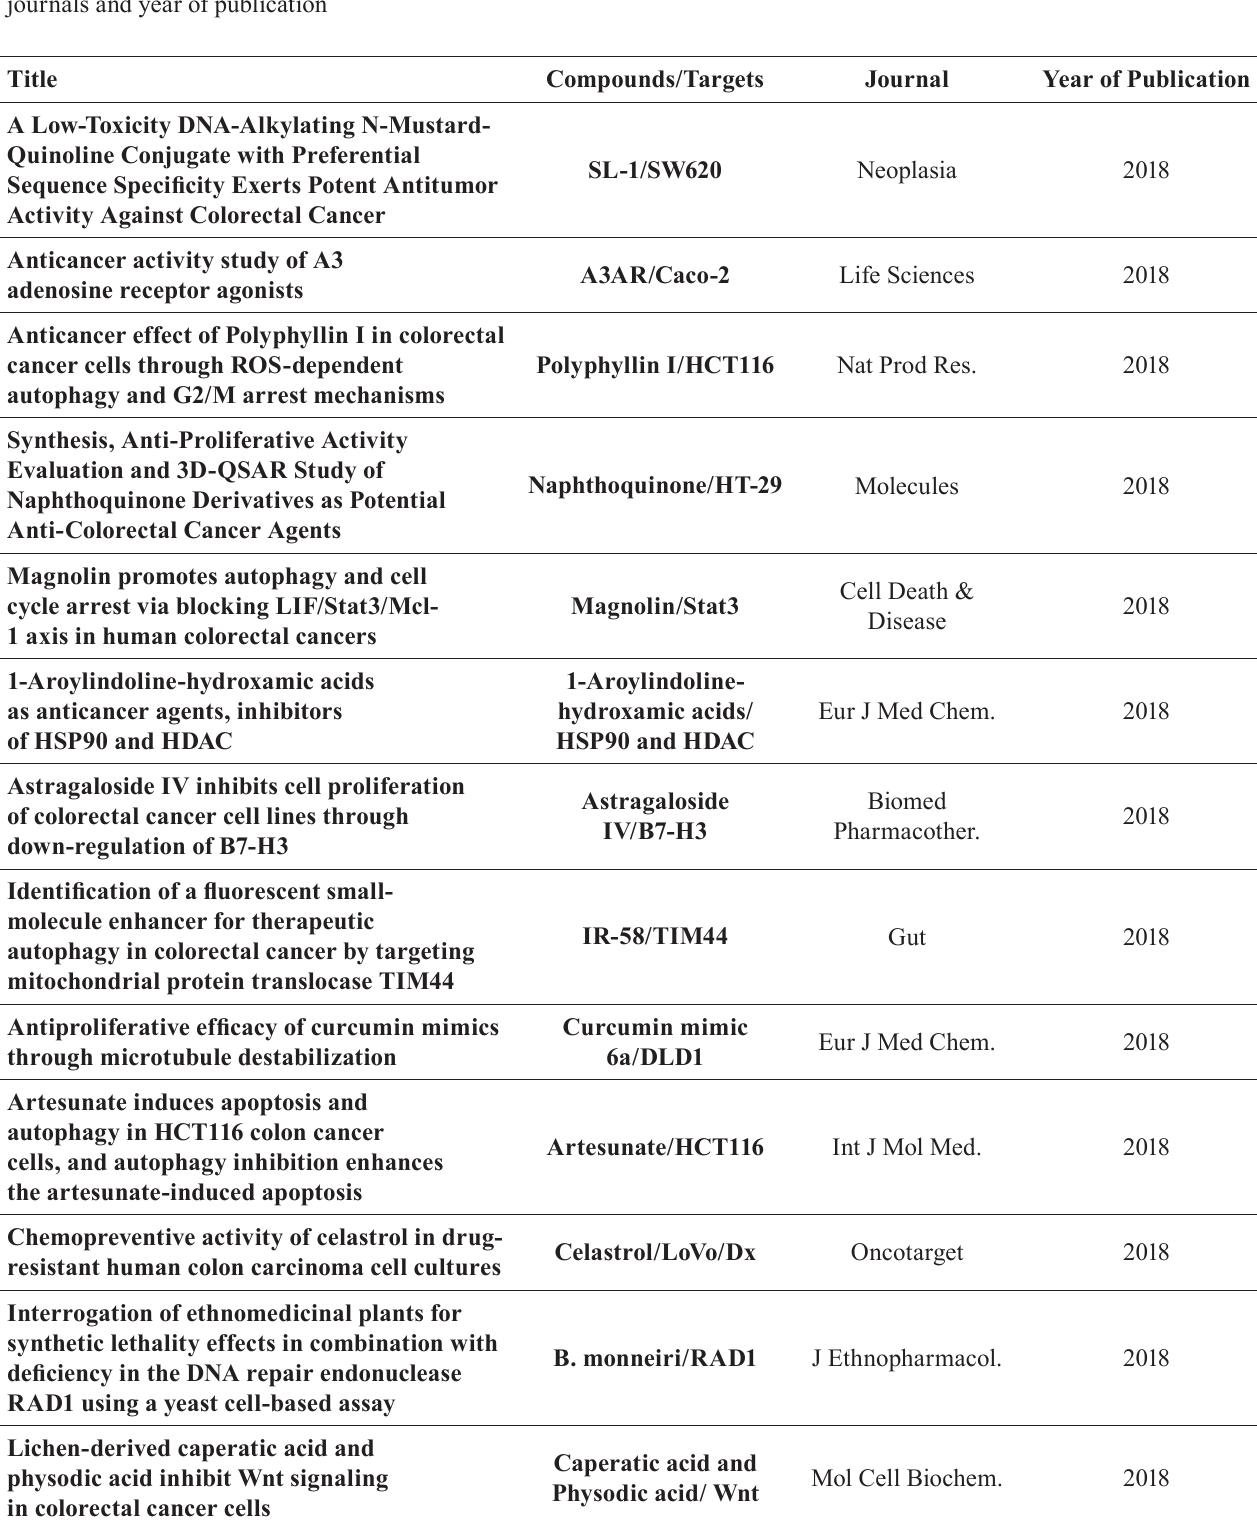
TABLE II – Potential CRC-related drugs identified in PubMed articles, followed by related tumor targets and their